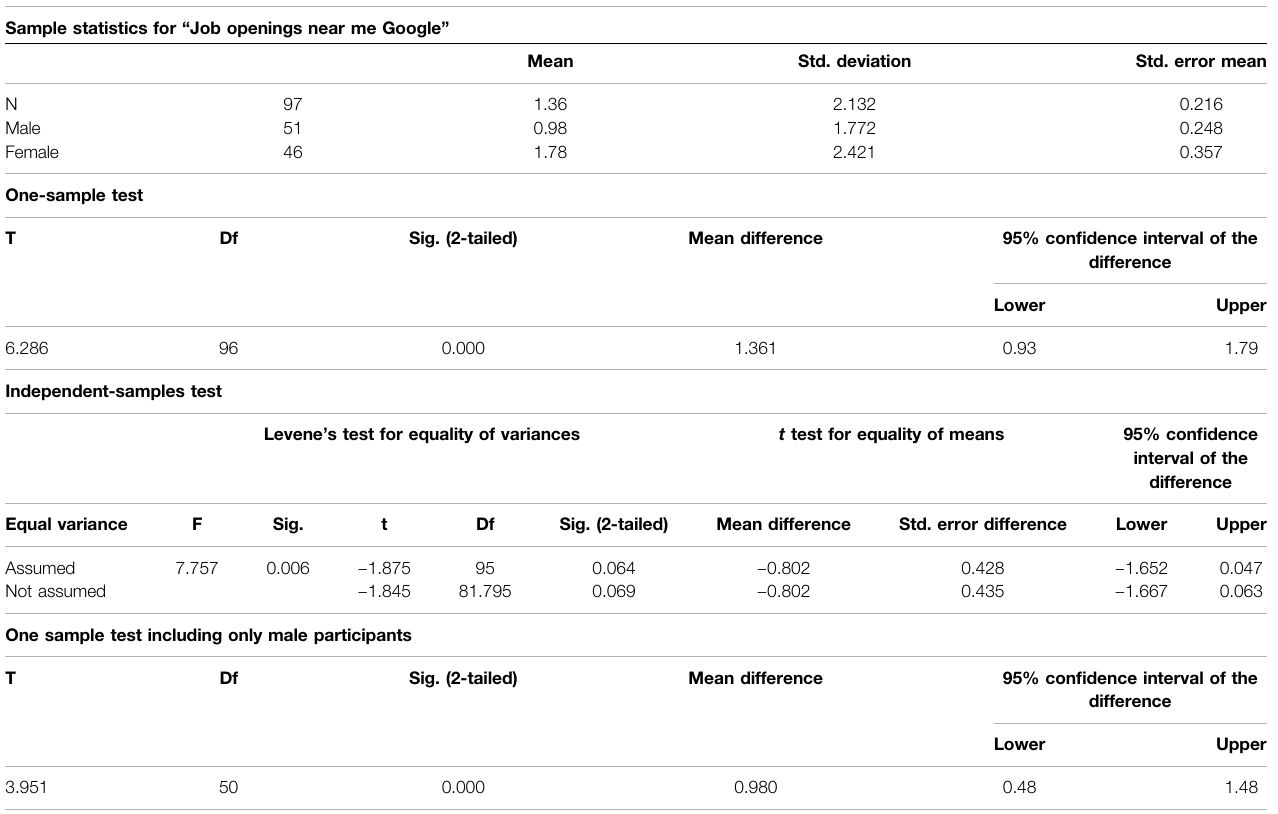
TABLE 2 | SPSS output for “ Job openings near me Google. ”